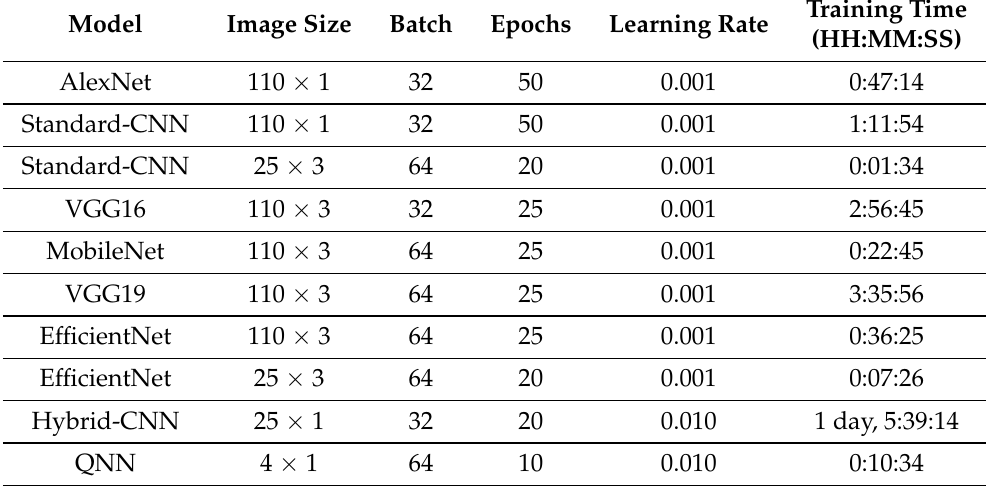
Table 1. The hyperparameters of the models employed in the experimental analysis to compare convolutional and quantum deep learning networks for Android malware detection.